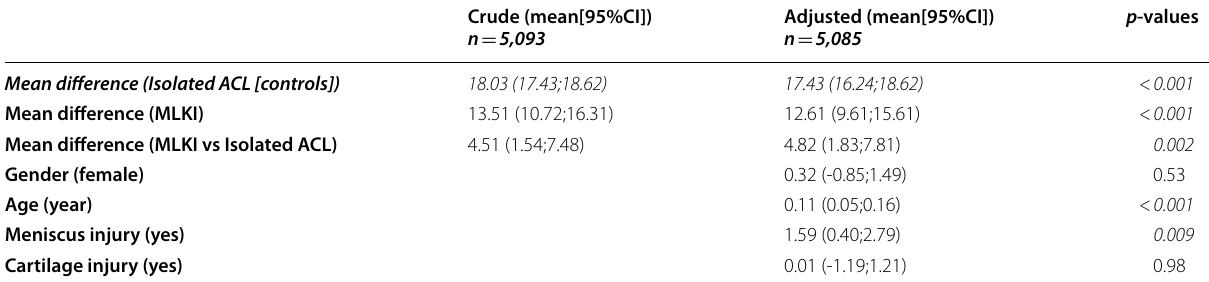
Table 3 Crude and adjusted differences in the KOOS QoL sub-scores of the MLKI group between baseline and 1-year follow-up and the impact of risk factors (gender, age, meniscus and cartilage injury)